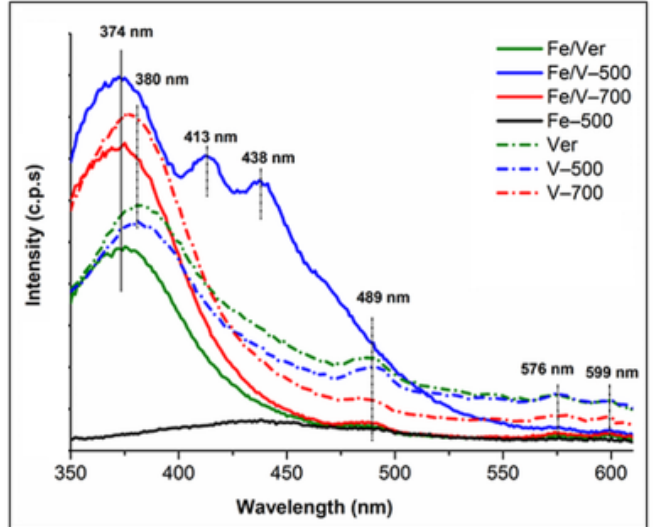
Figure 6. PL emission spectra of vermiculites, α -Fe 2 O 3 nanoparticles and α -Fe 2 O 3 /vermiculite com- posites.